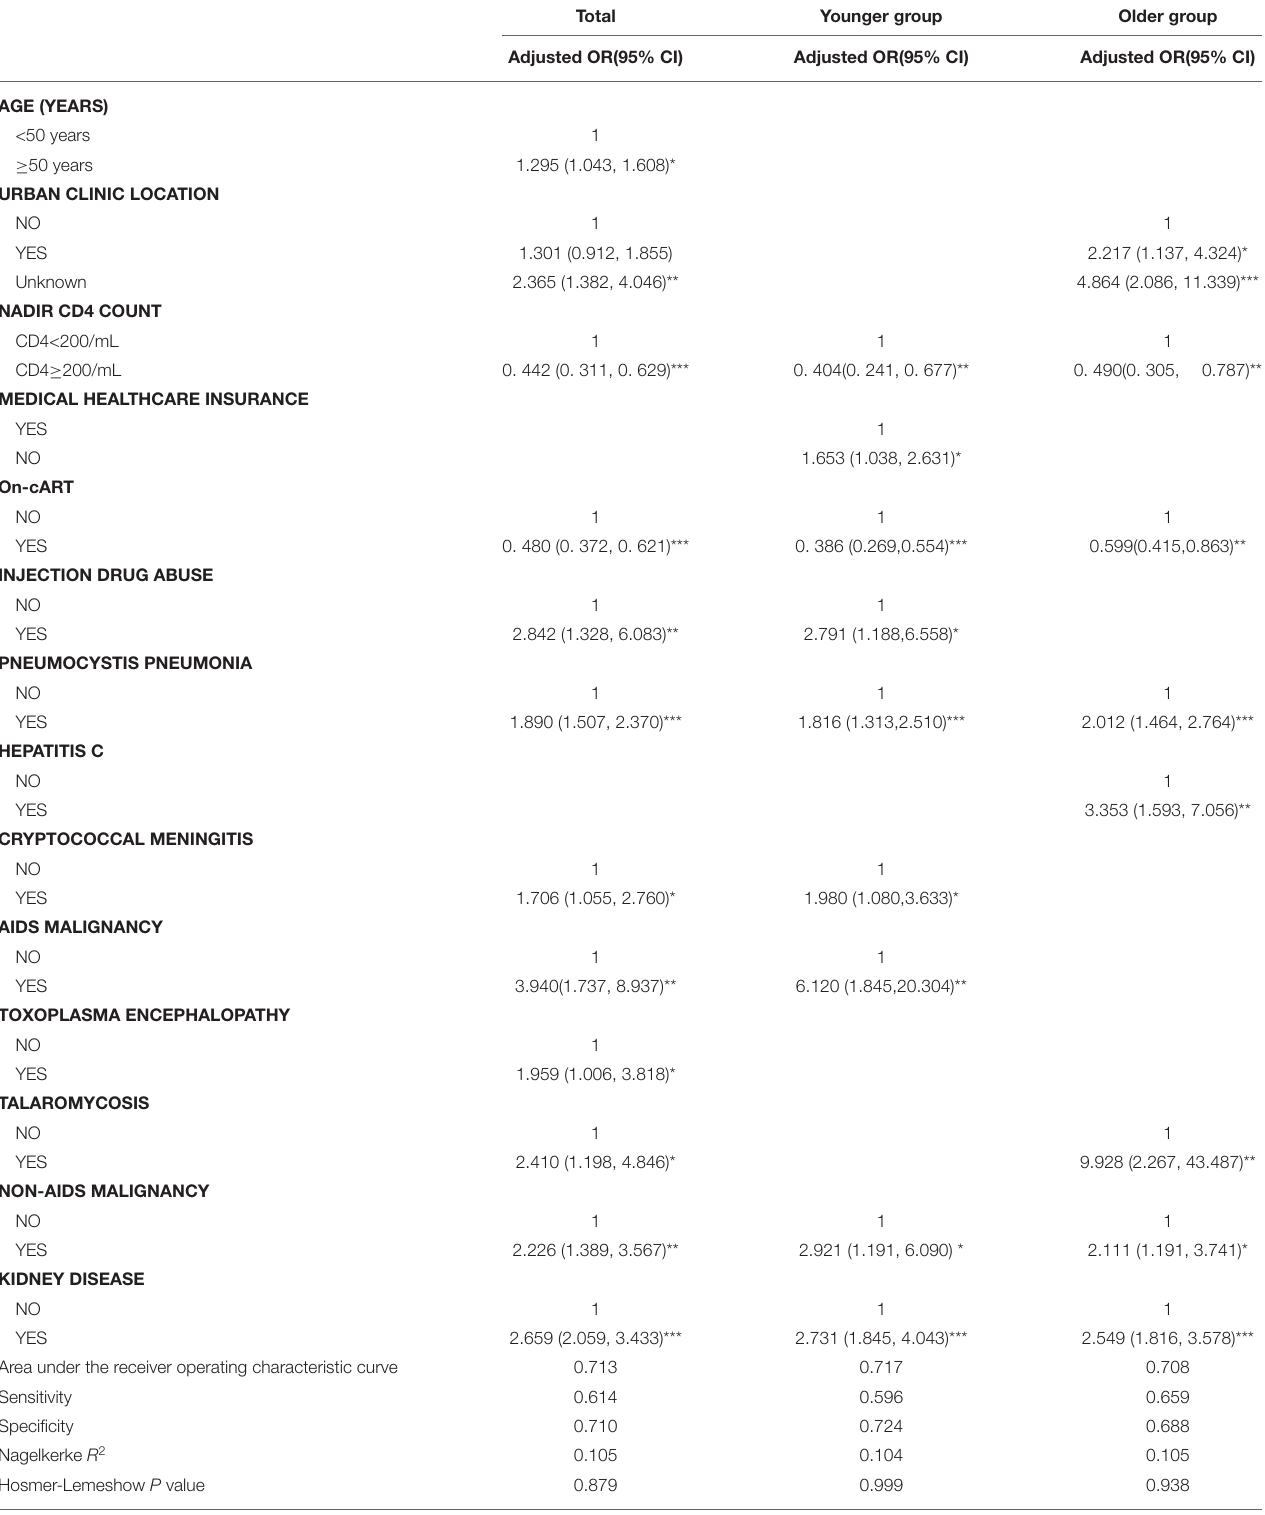
TABLE 4 | Independent predictors of mortality in hospitalized